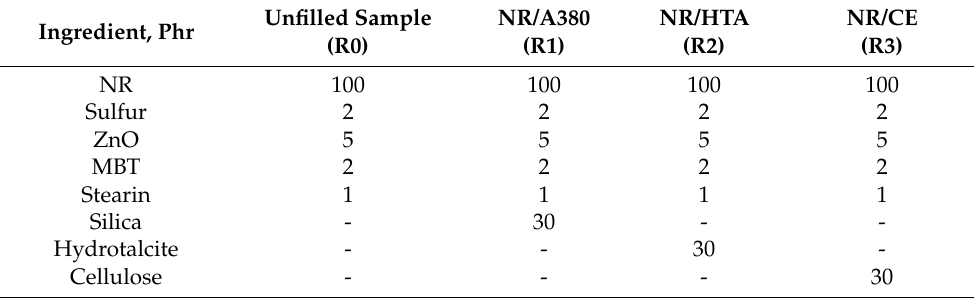
Table 2. General recipes of natural rubber (NR) reference compounds, parts per hundred of rubber (phr); (MBT, 2-mercaptobenzothiazole).